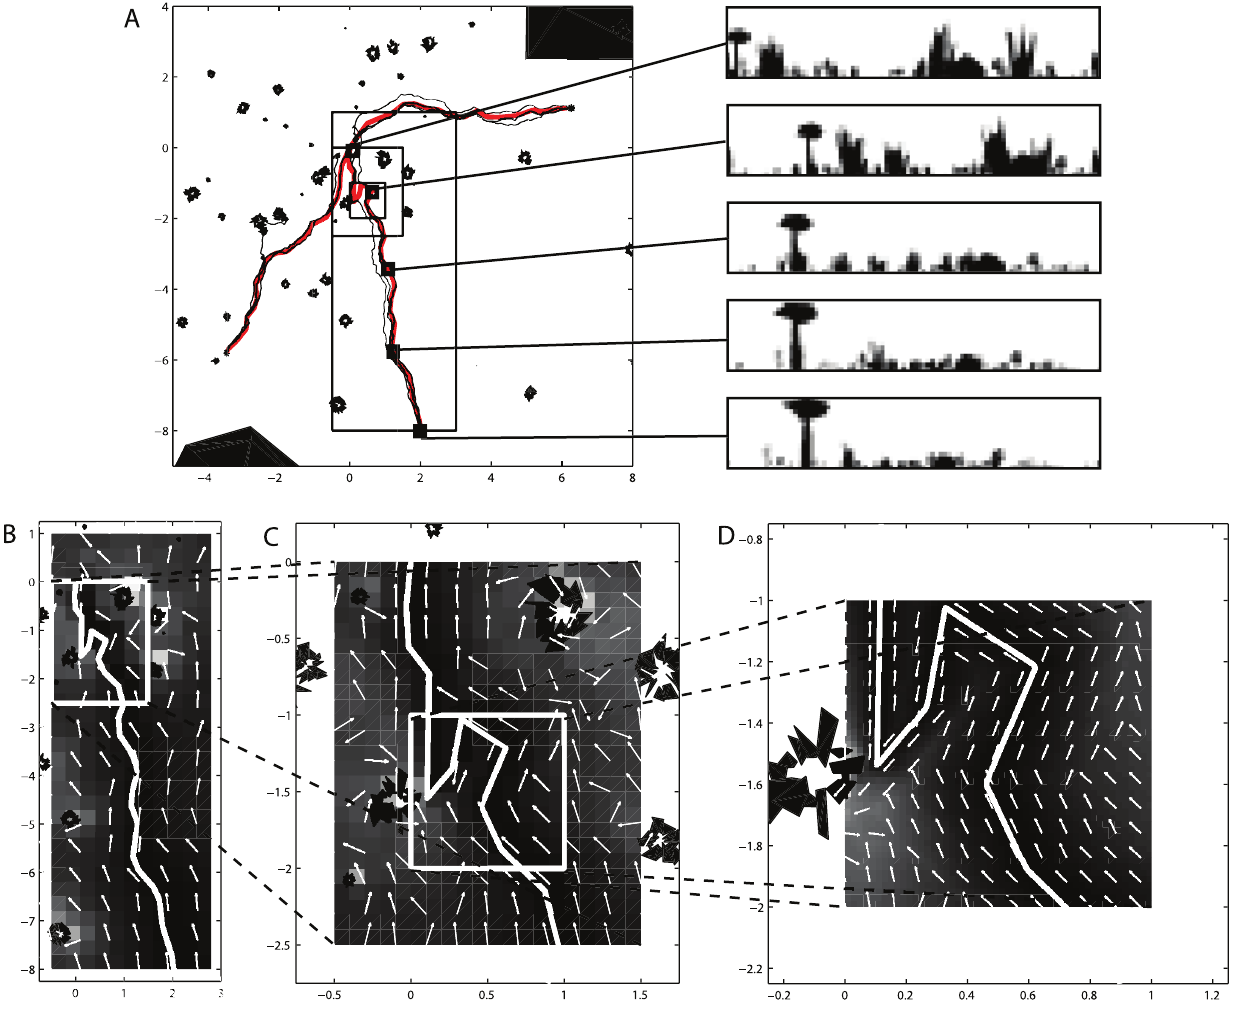
Figure 1. Navigating with a perfect memory. A) Three separate routes (red lines) learned in an environment containing both small and large objects. For each of the three routes, that consisted of between 700 and 980 views taken every 1 cm, we show three recapitulations (black lines). During route recapitulations the headings at each step were subject to normally distributed noise with a standard deviation of & 15 o . The panels to the right of the main figure show example views from points (indicated by squares) along the training route. B,C,D) Various sections of the middle route at a variety of different scales. The figures show the result of running the navigation algorithm at each point within a grid and indicate what action would be taken by an agent placed at that location. The white line indicates the training path and the white arrows indicate the directions that would be chosen from those locations. The underlying pseudocolour plot indicates the quality of the best match to the stored views for each position, with darker hues indicating a better